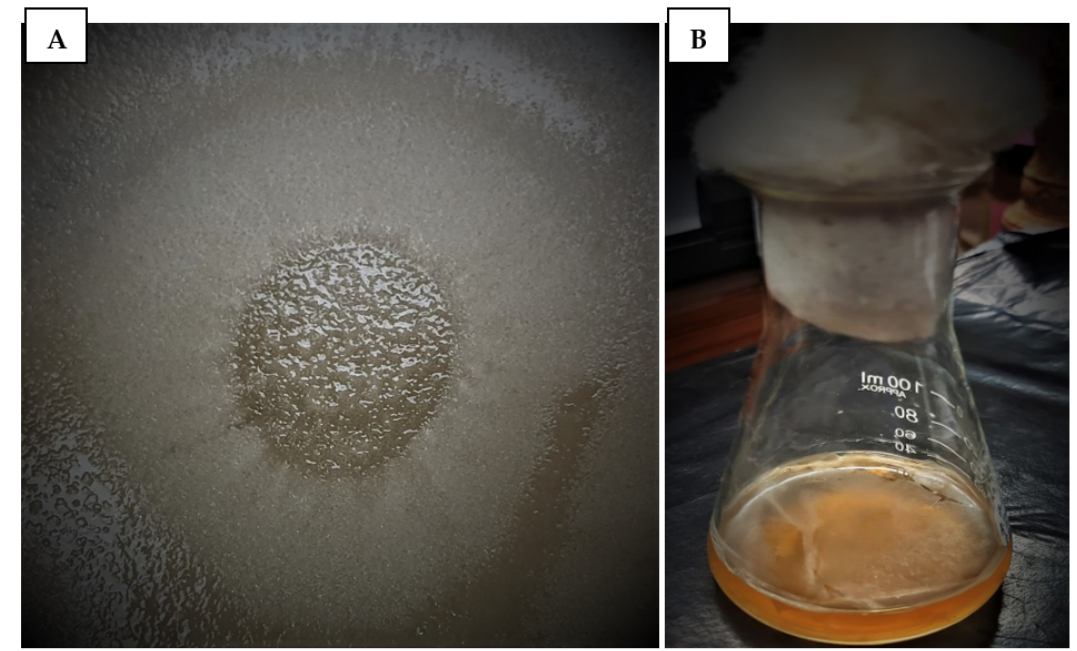
Figure 1. Aphanomyces invadans culture used in fish challenge experiments. ( A ) The fungal isolate was grown in potato dextrose agar (PDA) plates. ( B ) A. invadans cultured in potato dextrose broth (PDB) were used for different